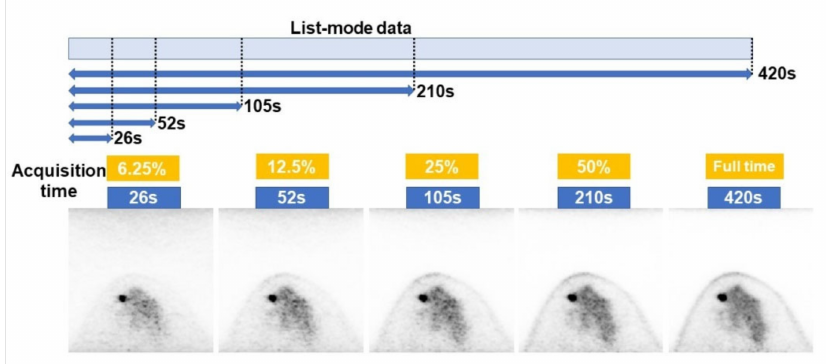
Figure 1. Image reconstruction with divided list-mode data. Images reconstructed from data acquired for 420 s. The list-mode data of the breast were divided into 26 s (6.25%), 52 s (12.5%), 105 s (25%), and 210 s (50%) from the start and reconstructed.